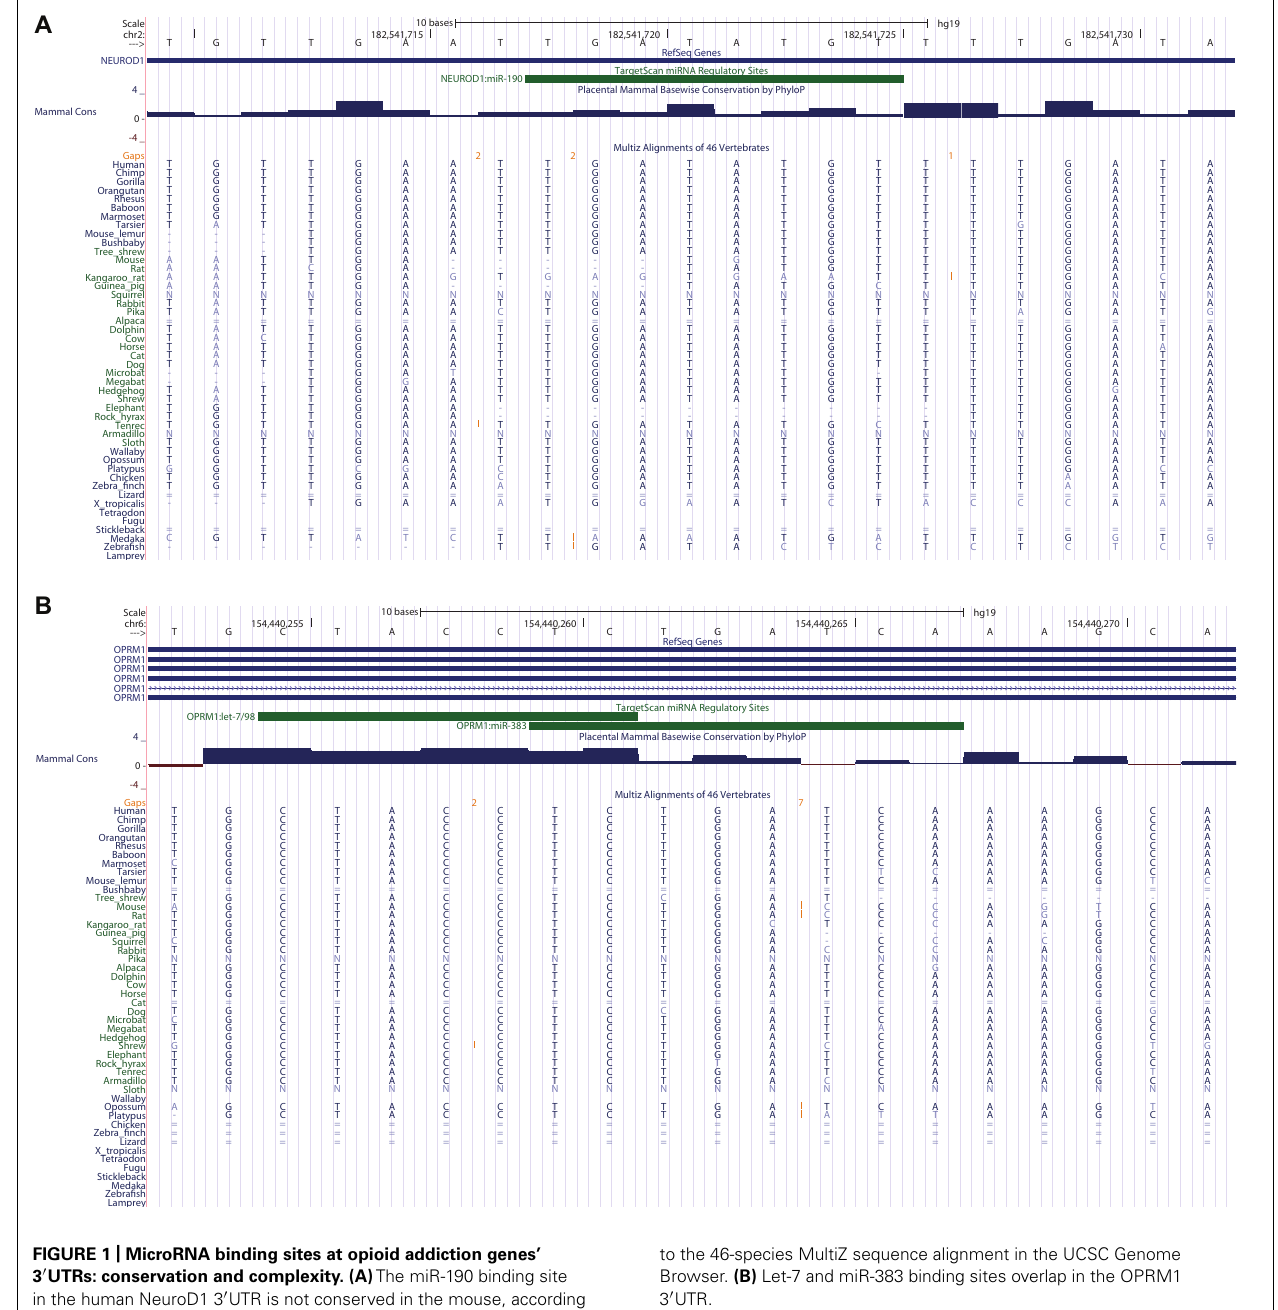
to the 46-species MultiZ sequence alignment in the UCSC Genome Browser. (B) Let-7 and miR-383 binding sites overlap in the OPRM1 3 (cid:2)